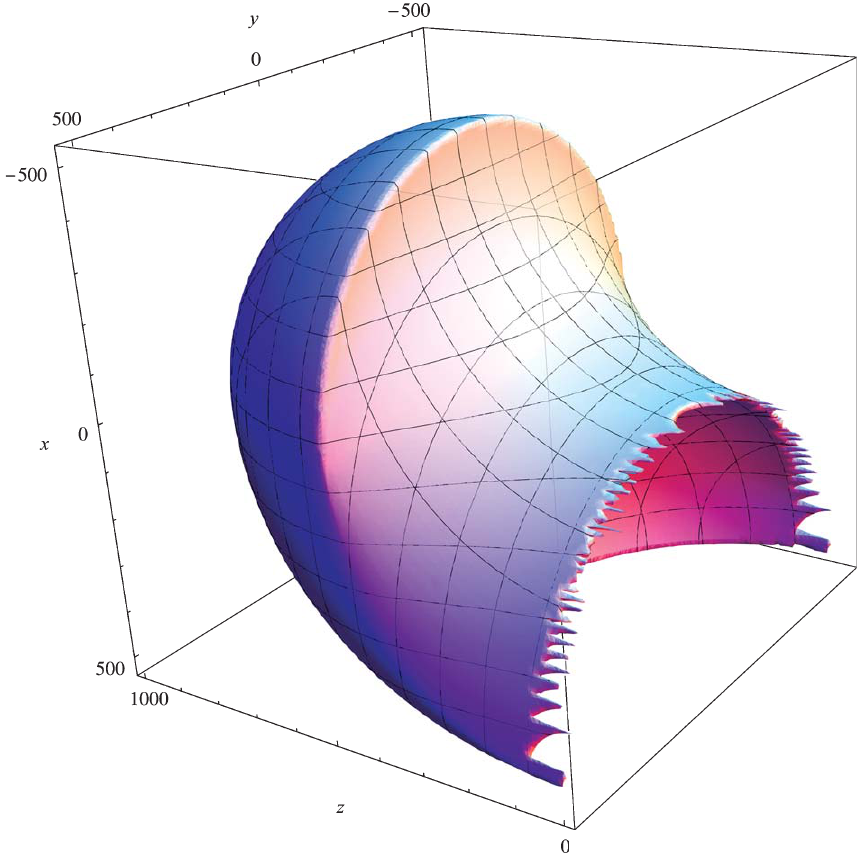
Fig. 14. 3D representation of the workspace of point M, for a single limb (example with d = 500 and l = 1000 is